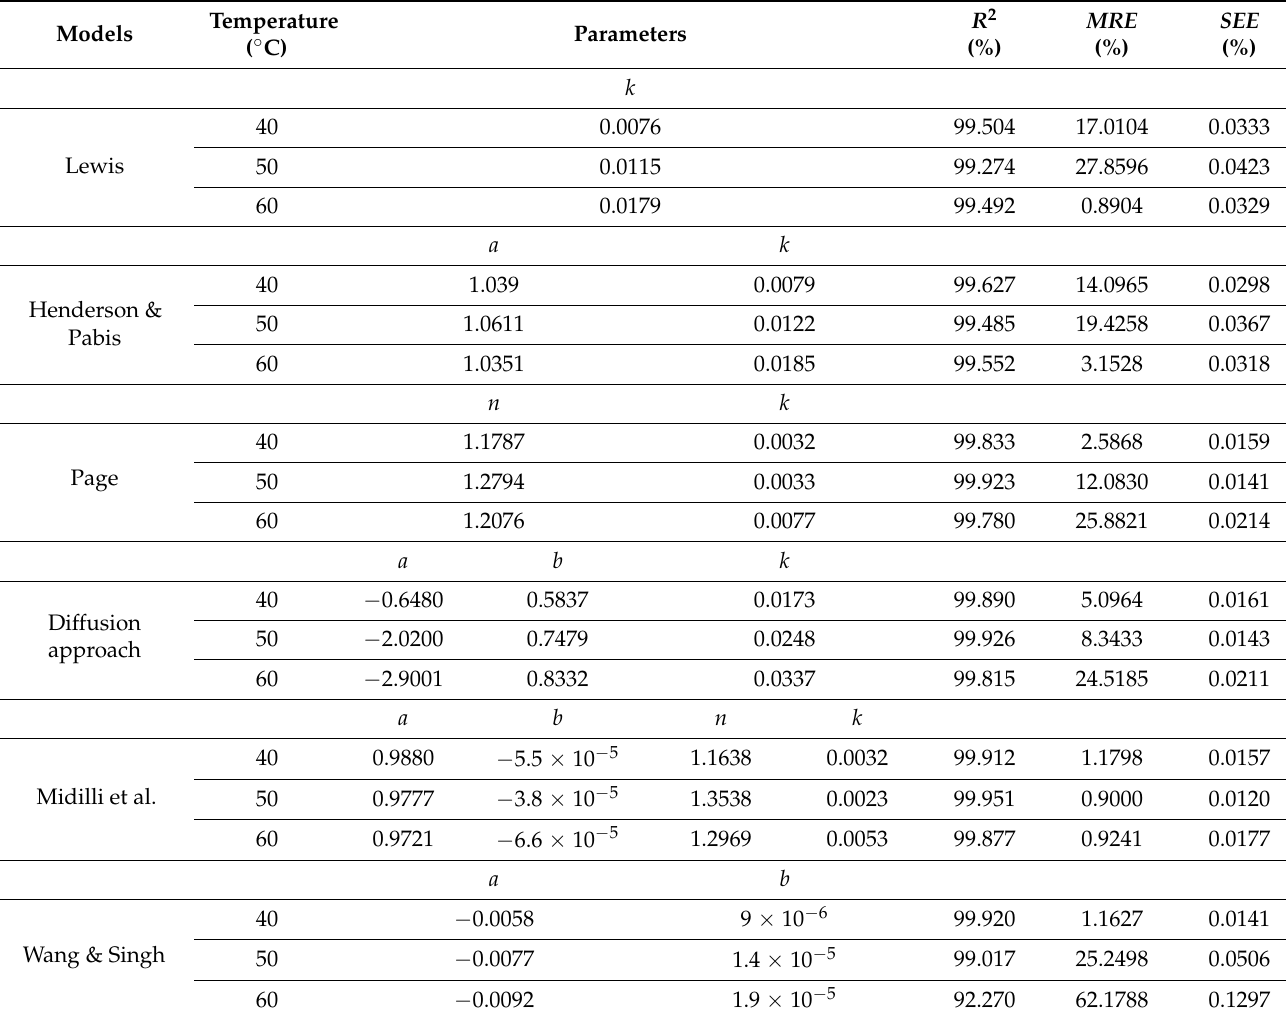
Table 1. Parameters of the models applied to the experimental data analyses of the drying kinetic curves of Lippia thymoides leaves.